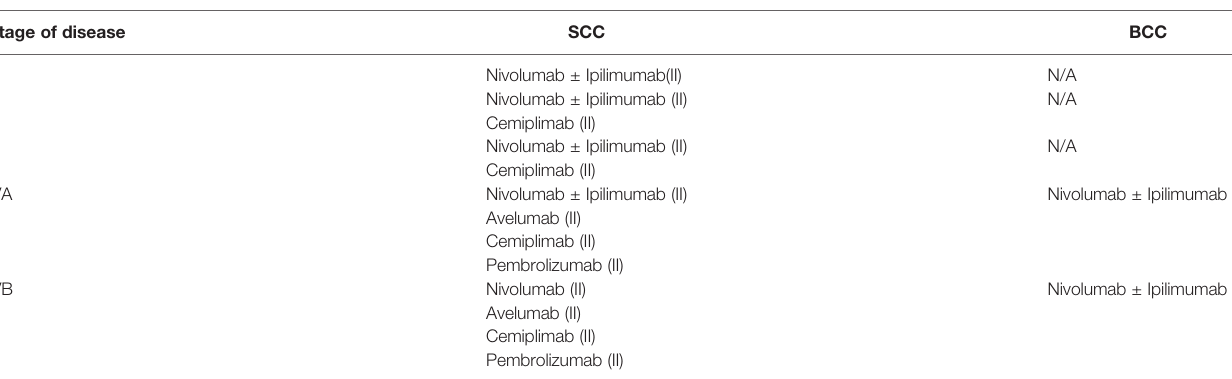
TABLE 2 | Immune Checkpoint inhibitors. Stage of